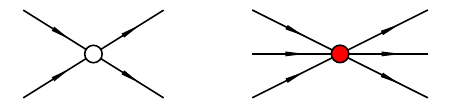
Figure 1: 2-body operator and 3-body